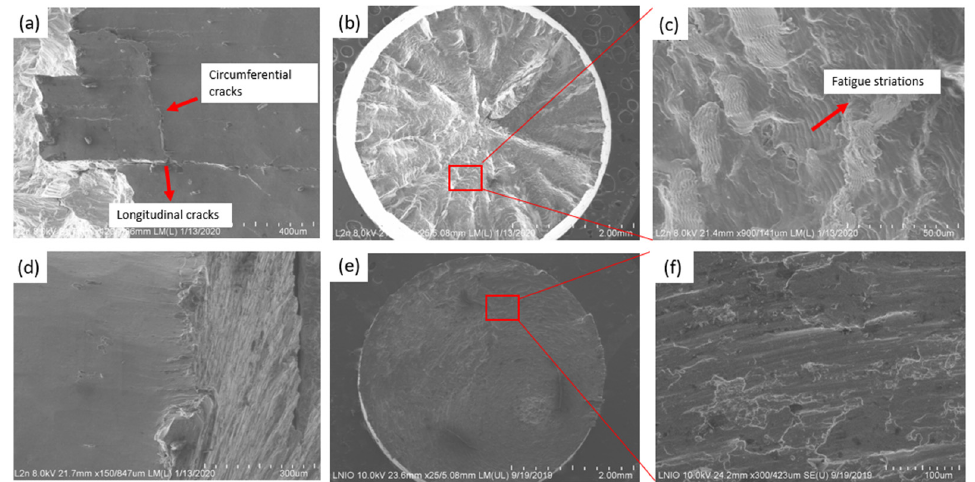
Figure 7. Fracture morphologies of HT-SMAT samples: ( a – c ) correspond to 220 MPa and ( d – f ) correspond to 170 MPa. Among these figures, circumferential surfaces ( a , d ), fracture surfaces ( b , e ), and magnified views ( c , f ) of red rectangles shown in ( b , e ) are shown, respectively.